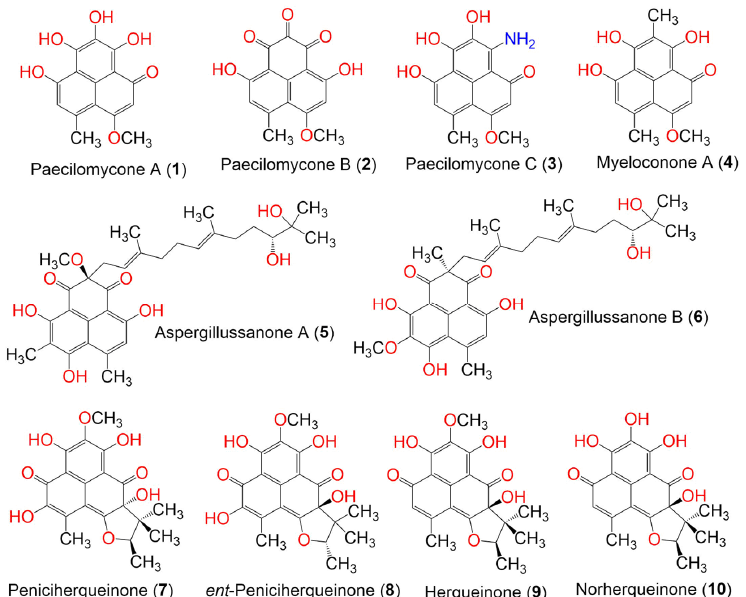
Figure 1. The structures of compounds 1–10 .